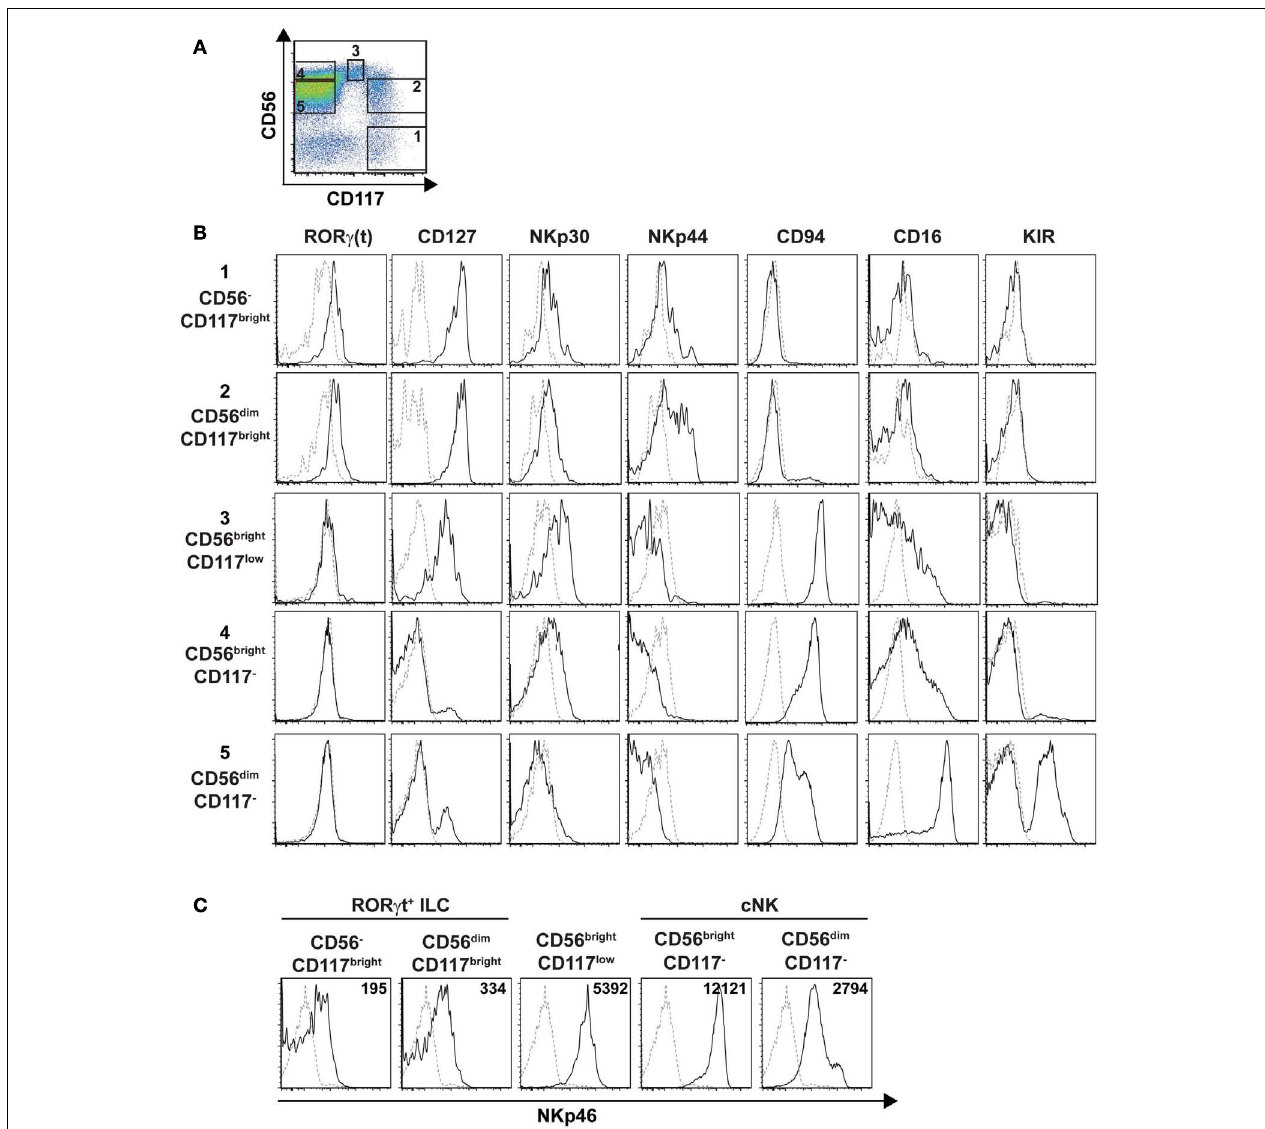
cells; (5) CD56 dim CD117 − cells. (B,C) Expression of the indicated ILC or NK cell markers (B) or of the NKp46 cell marker (C) on indicated splenic cell subsets defined as in (A) . Black line, specific staining; dashed line, isotype control staining in (B) or staining on CD56 − CD117 − cells in (C) . Numbers in (C) represent the mean fluorescence intensity of NKp46 expression in indicated cell